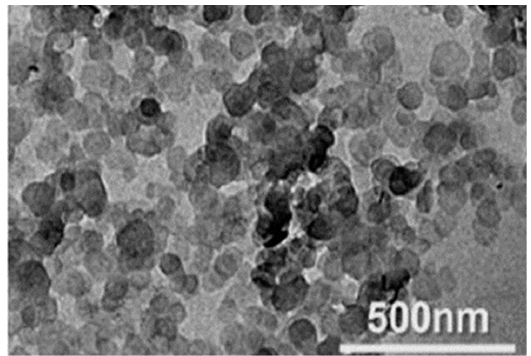
Figure 5. TEM image of a well-dispersed LDH prepared using microreactor under continuous process. Reproduced with permission from reference [92].